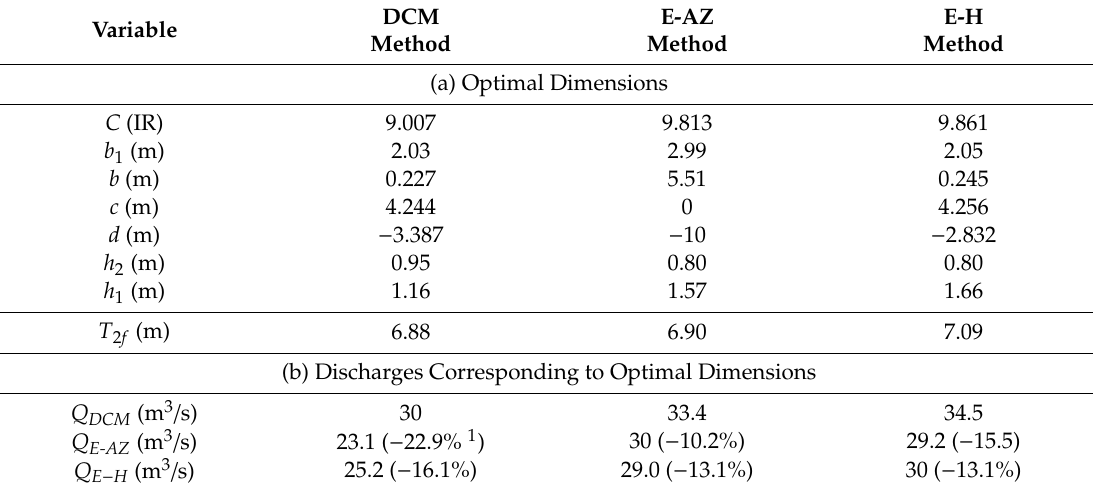
Table 5. Comparison of optimal results of the three discharge methods for the compound